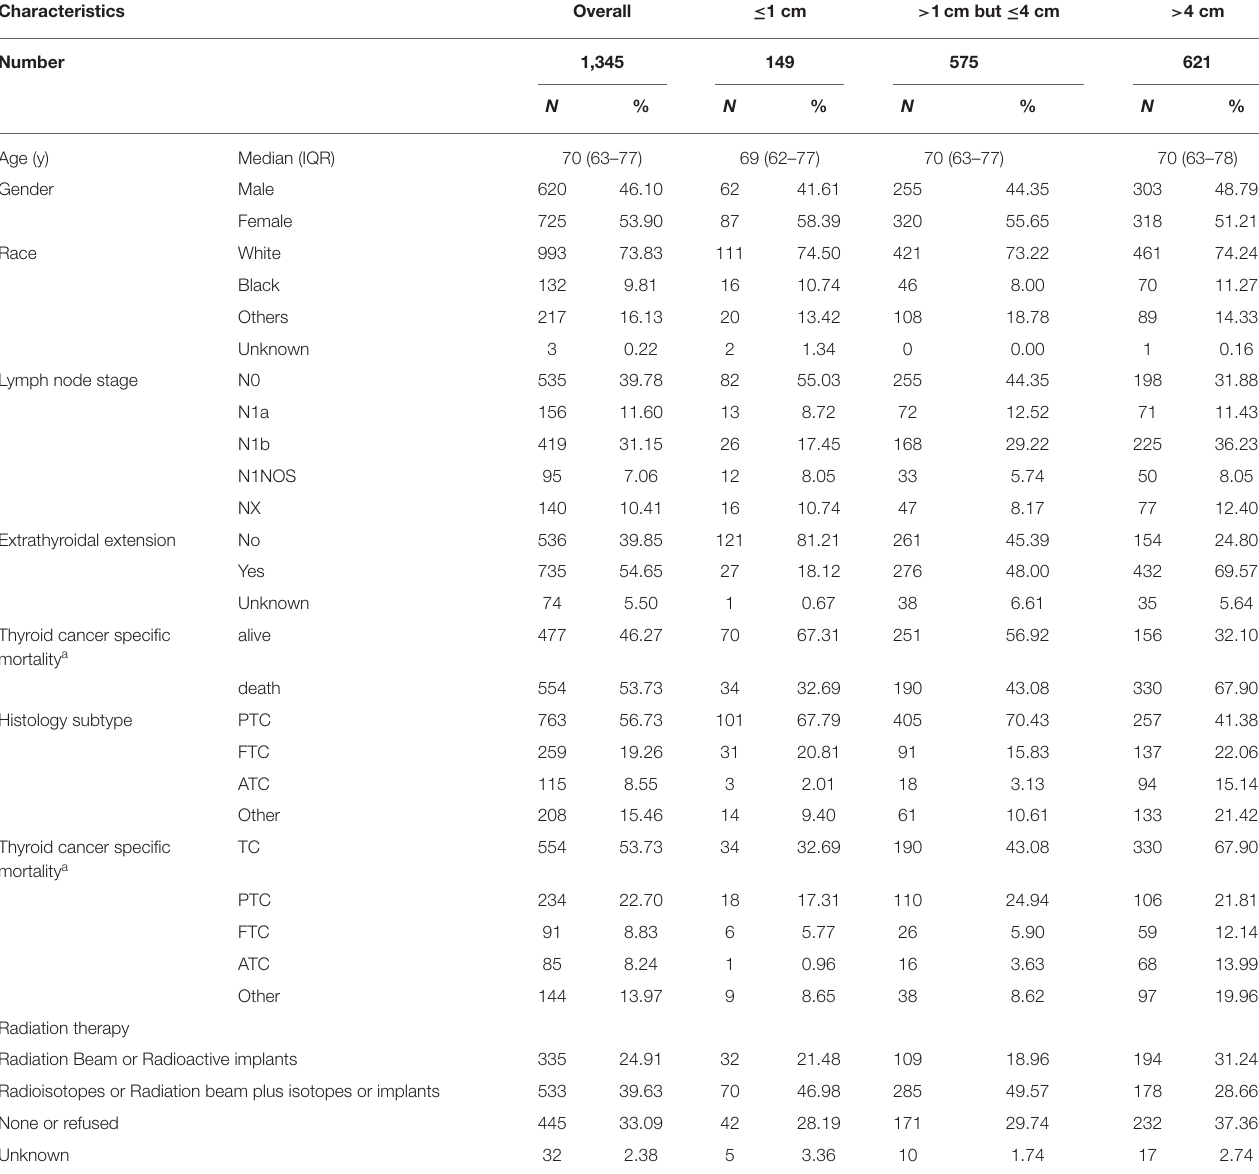
TABLE 1 | The clinical characteristics of thyroid cancer with increased tumor size (SEER database years of 2004 − 2016).